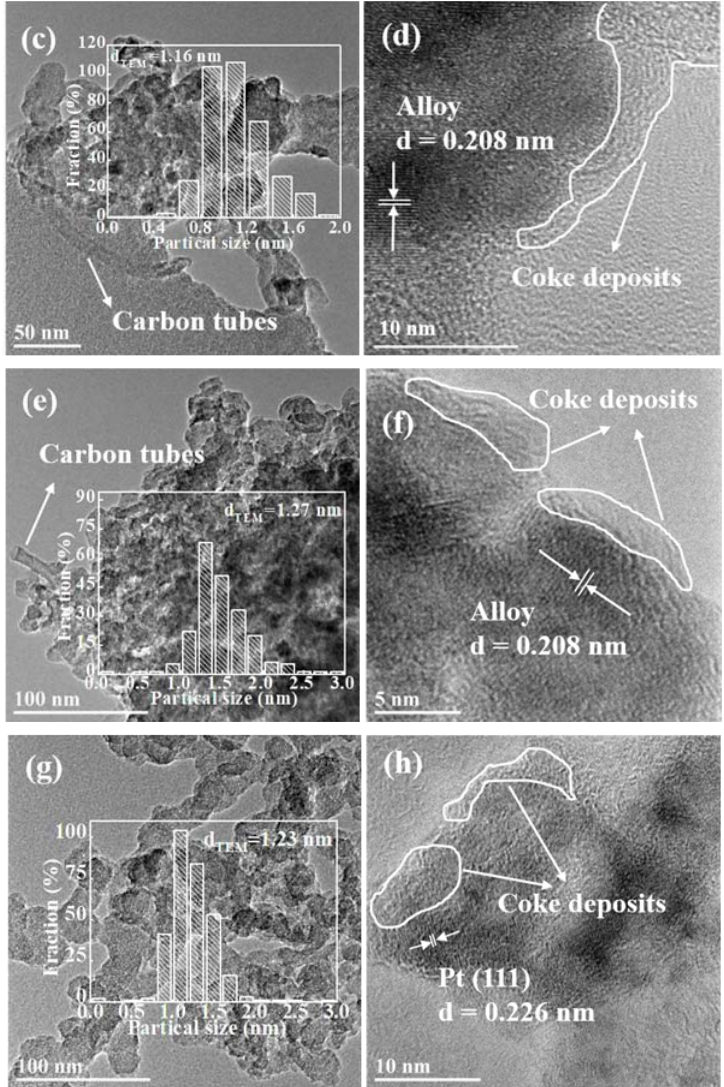
Figure 6. TEM images and the statistics of PSD in the insets of the used PtIn/MAZ catalytic system reduced with different atmospheres: ( a , b ) H 2 /N 2 ; ( c , d ) C 3 H 8 /H 2 /N 2 ; ( e , f ) C 3 H 8 ; ( g , h ) CO (reduction conditions: T = 600 °C, t = 2.5 h; reaction conditions: T = 600 °C, WSHV = 3 h − 1 , atmospheric pressure in the gas mixture of C 3 H 8 :H 2 :N 2 molar ratio = 8:7:35 for 17 h).